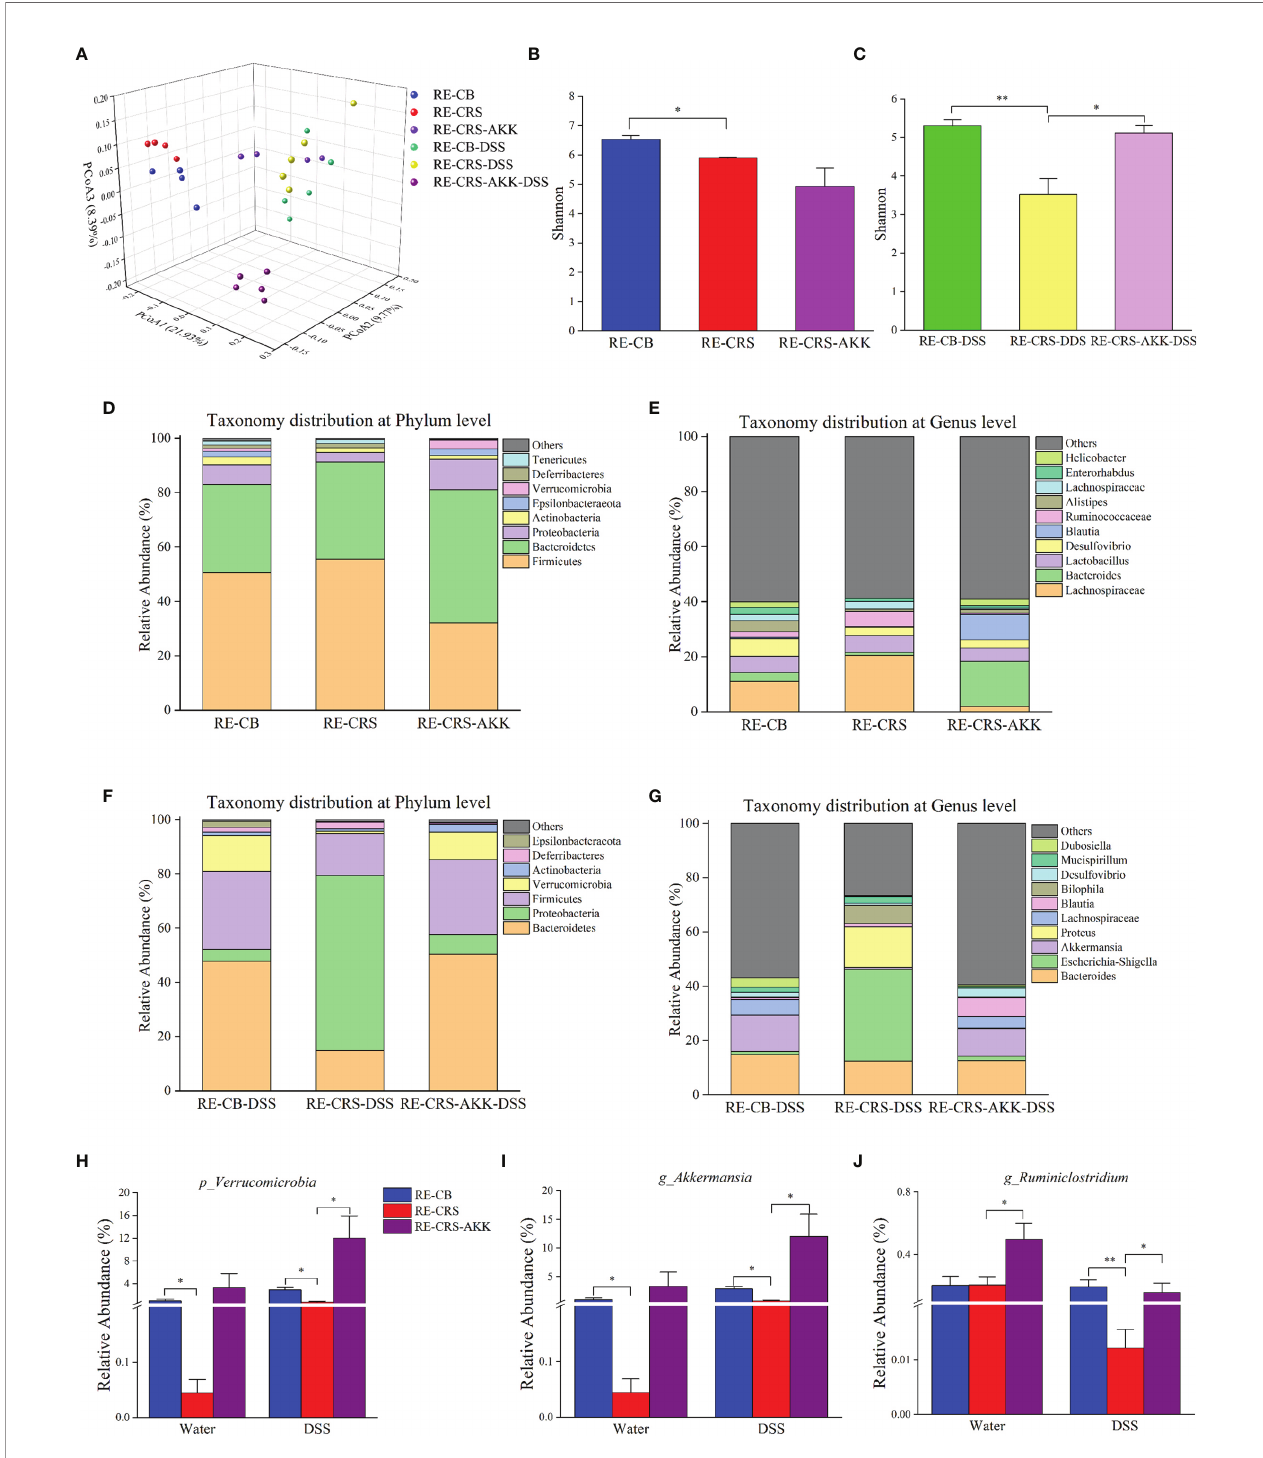
FIGURE 9 | A. muciniphila supplementation remodeled the gut microbiota in recipient mice. (A) PCoA according to unweighted Unifrac revealed site-speci fi c clustering (n = 4 – 5). (B, C) The alpha diversity, Shannon index were shown in each recipient group; (D – G) relative abundance compositions of microbiota at the phylum and genus level presented in each recipient group. (H) The representative phylum of Verrucomicrobia was differentially represented after A. muciniphila treatment in recipient mice. (I – J) Two representative genera were differentially represented after A. muciniphila . *p < 0.05, **p <